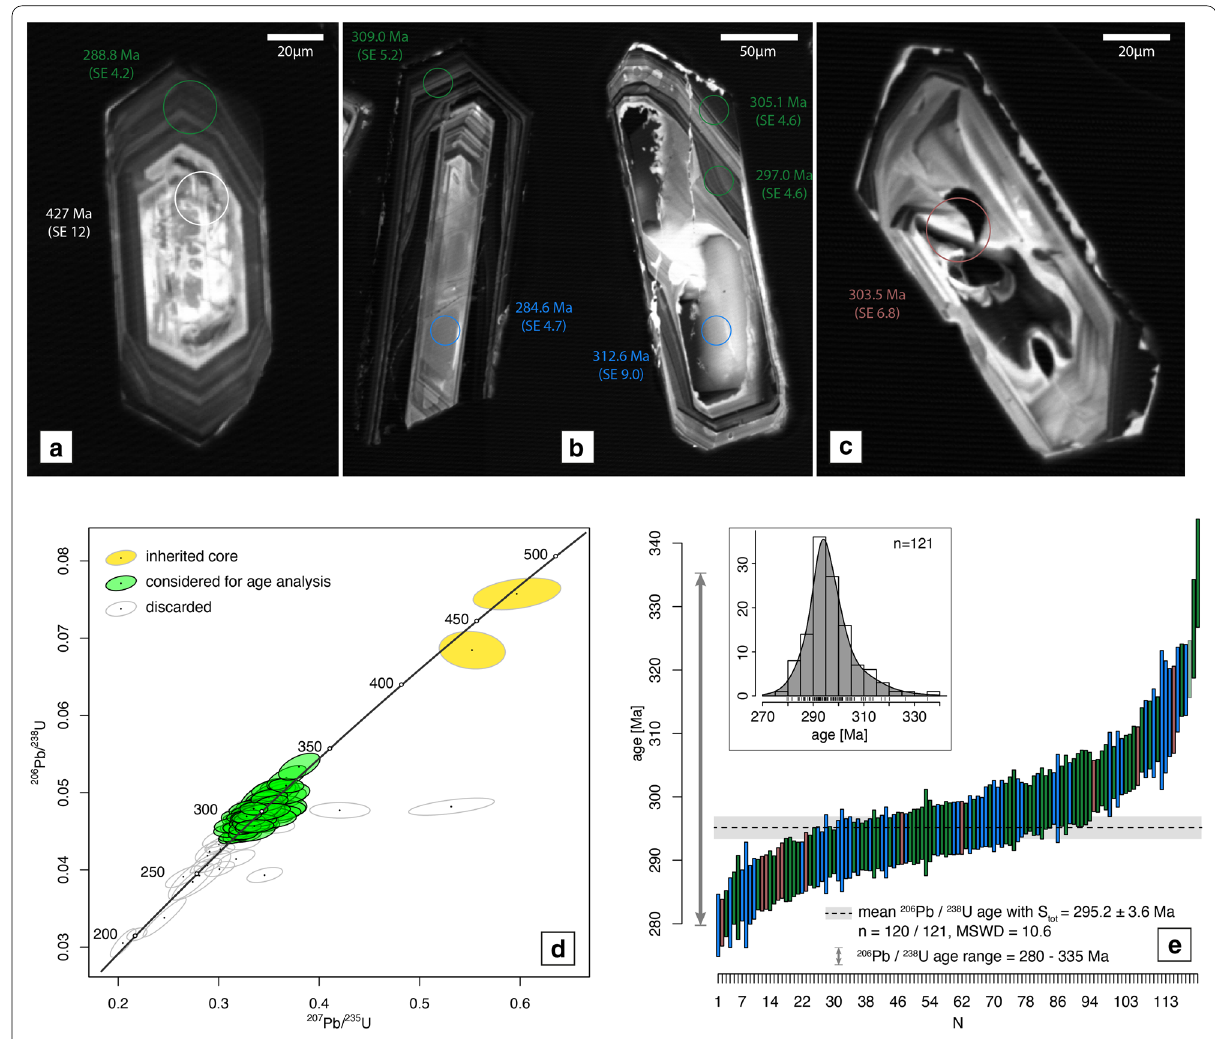
Fig. 15 Images and data of zircons separated from a RG2 sample (B20-3247). a – c CL-images, circles show LA-ICP-MS spots and numbers next to it show the corresponding 206 Pb / 238 U -age with one standard error (in brackets). Green spots indicate LA-ICP-MS measurements of rims with oscillatory zoning ( a and b ), the white spot of an inherited core ( a ), blue spots of zircon centers ( b ), and the red spot of a domain with blurred zoning ( c ). d Concordia diagram of all LA-ICP-MS measurements. Data highlighted in green correspond to data shown in subfigure ( e ) and are potentially respected for the age determination. Data points with indications of inherited cores are marked in yellow. Basis for discarding additional data (non-filled error ellipses) is indicated in Additional file 4. Error ellipses correspond to two standard errors. e 206 Pb / 238 U -ages of the potentially respected data for the age determination. Length of bars correspond to two standard errors. For the determination of the mean age and the age range, the brightened age data were discarded based on a modified version of Chauvenet’s criterion (Vermeesch, 2018). Colors indicate rims with oscillatory zoning texture (green), rims with other textures (red) and centers (blue). Inner figure shows a histogram of all 206 Pb / 238 U -ages shown